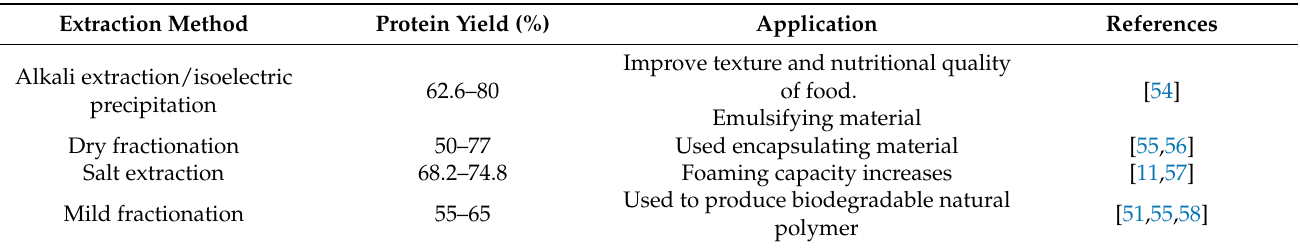
Table 1. Various extraction methods, yield, and